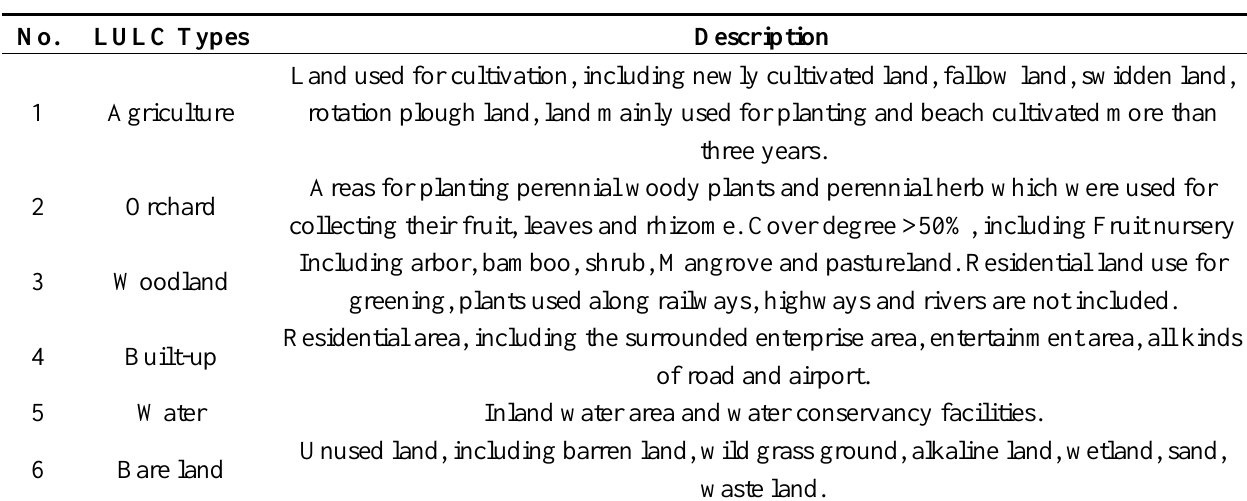
Table 2. The LULC classification scheme used in this